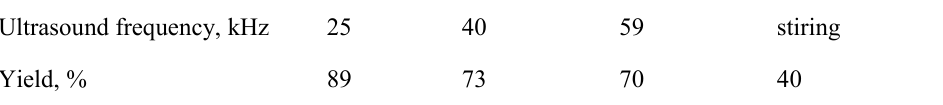
Table 2 The effect of ultrasound frequency on the oxidation of cyclohexanol to adipic acid*. Ultrasound frequency, kHz